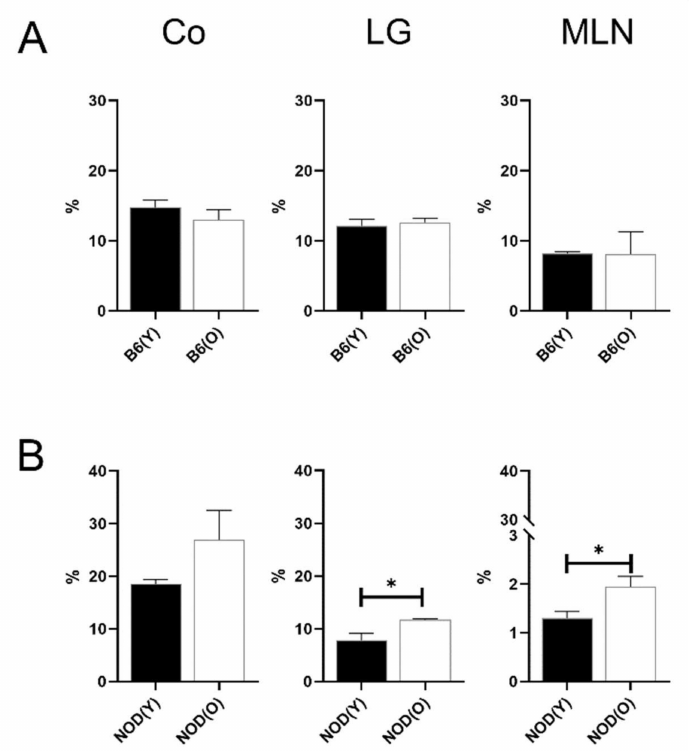
Figure 6. Distribution of MHC-II hi B cells in B6 ( A ) ( n = 4) and NOD.B10.H2 b ( B ) mice ( n = 4). The total number of CD45 + cells was used as the denominator to compensate for the actual fraction of each subset in corneolimbus and LG. In MLN, the percentage of subsets was calculated as the percentage within total cells. No significant proportional changes were observed in the MHC-II hi B cell in the corneolimbus, LG, and MLN of B6 mice. The percentage of lacrimal glandial MHC- II hi B cells was significantly higher in aged NOD.B10.H2 b mice compared to young NOD.B10.H2 b mice ( p = 0.023). The percentage of MLN MHC-II hi B cells was significantly higher in the aged NOD.B10.H2 b mice than in the young NOD.B10.H2 b mice ( p = 0.038). All experiment results were tested for statistical differences using unpaired, two-tailed independent t-tests. Data are expressed as the mean ± standard error of the mean. B6, C57BL/6; NOD, NOD.B10.H2 b ; DC, dendritic cell;